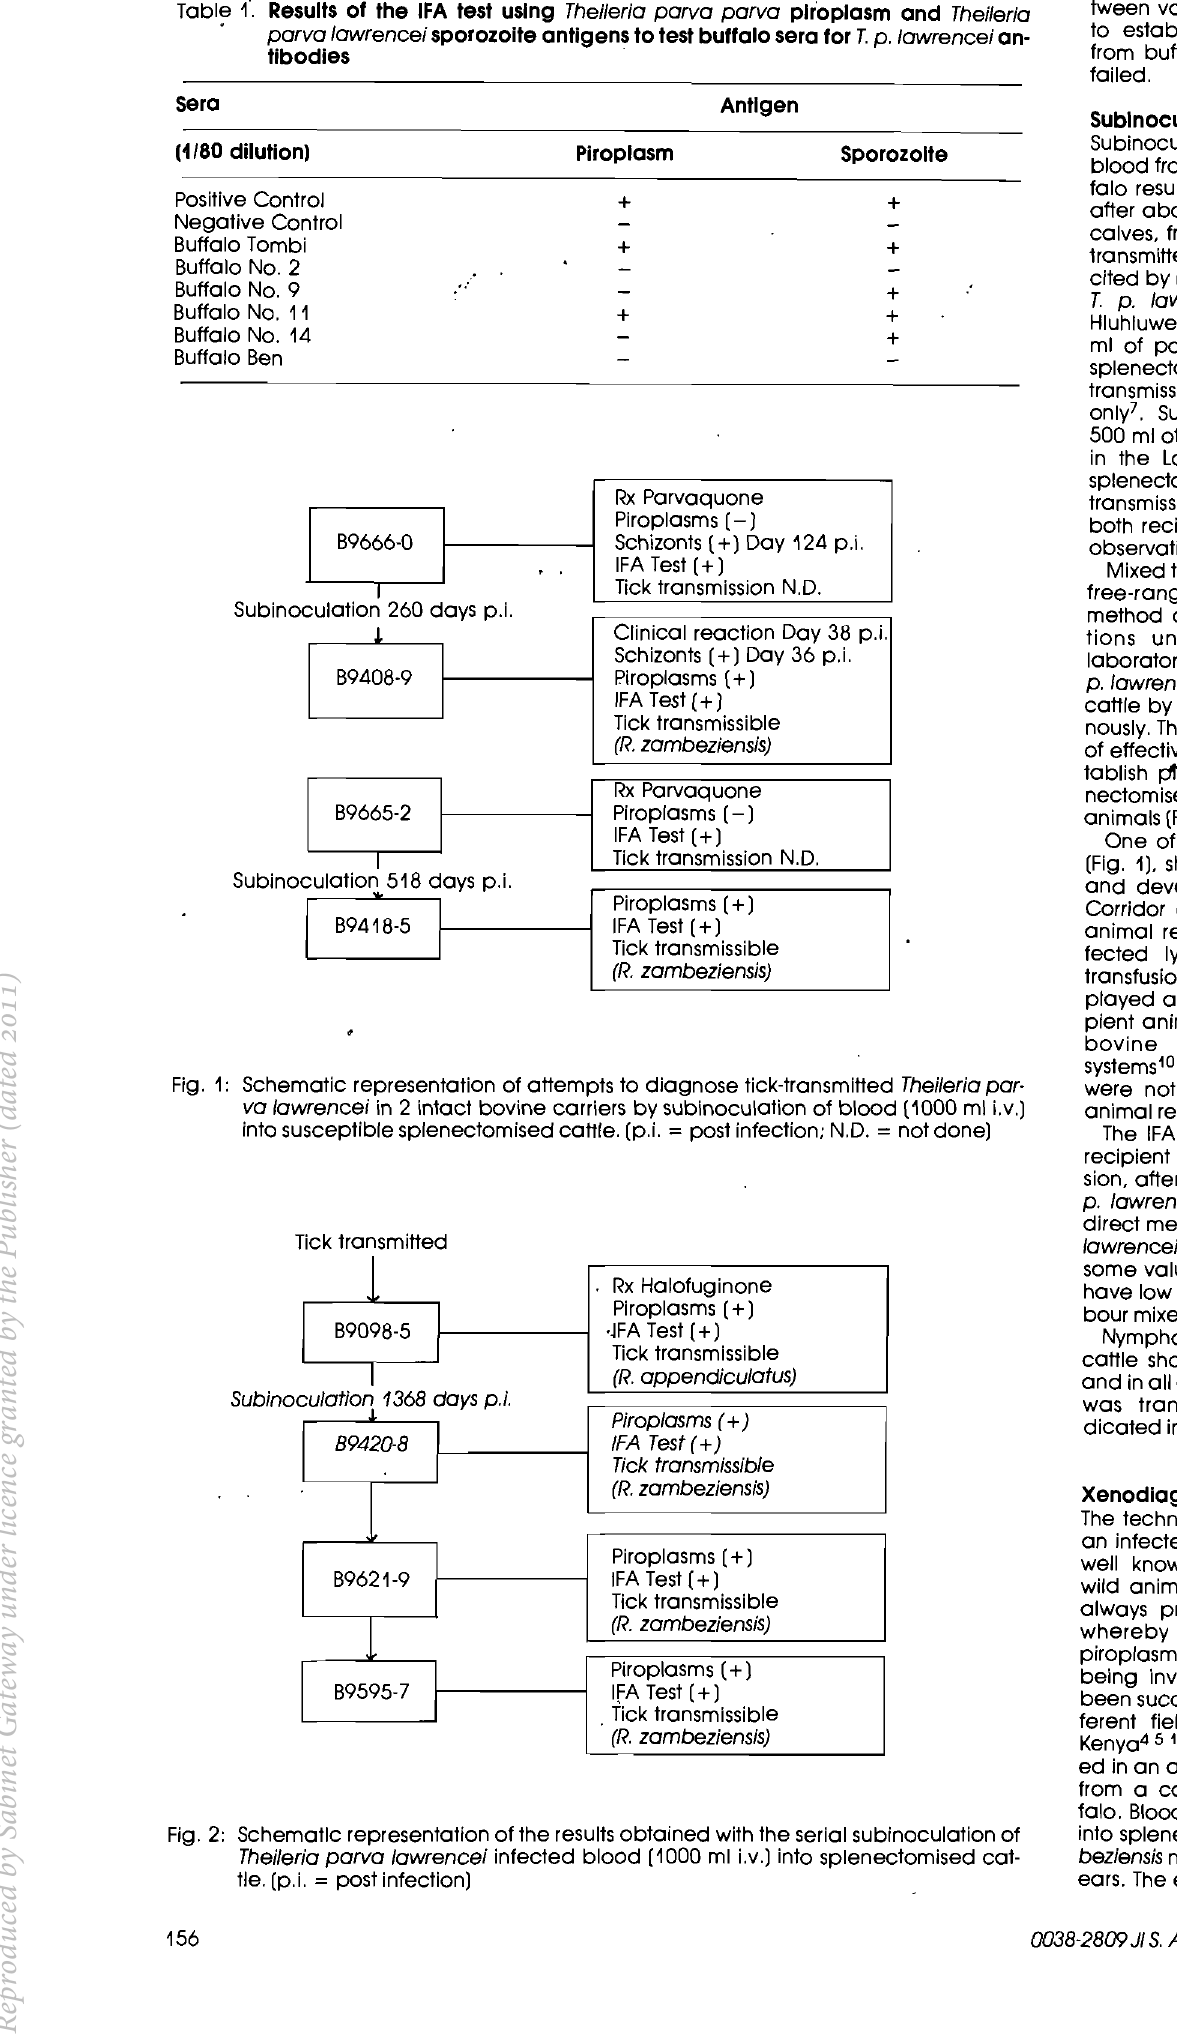
Table 1'. Results of the IFA test using Theileria parva parva piroplasm and Theileria parva lawrencei sporozoite antigens to test buffalo sera for T. p. lawrencei an tibodies Sera Antigen Piroplasm